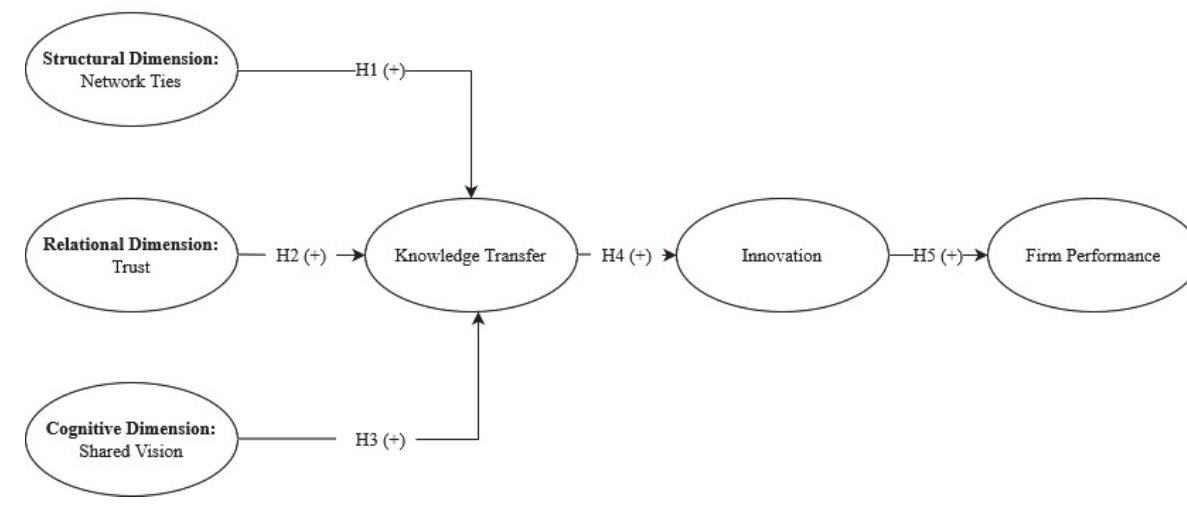
Fig. 1. The proposed